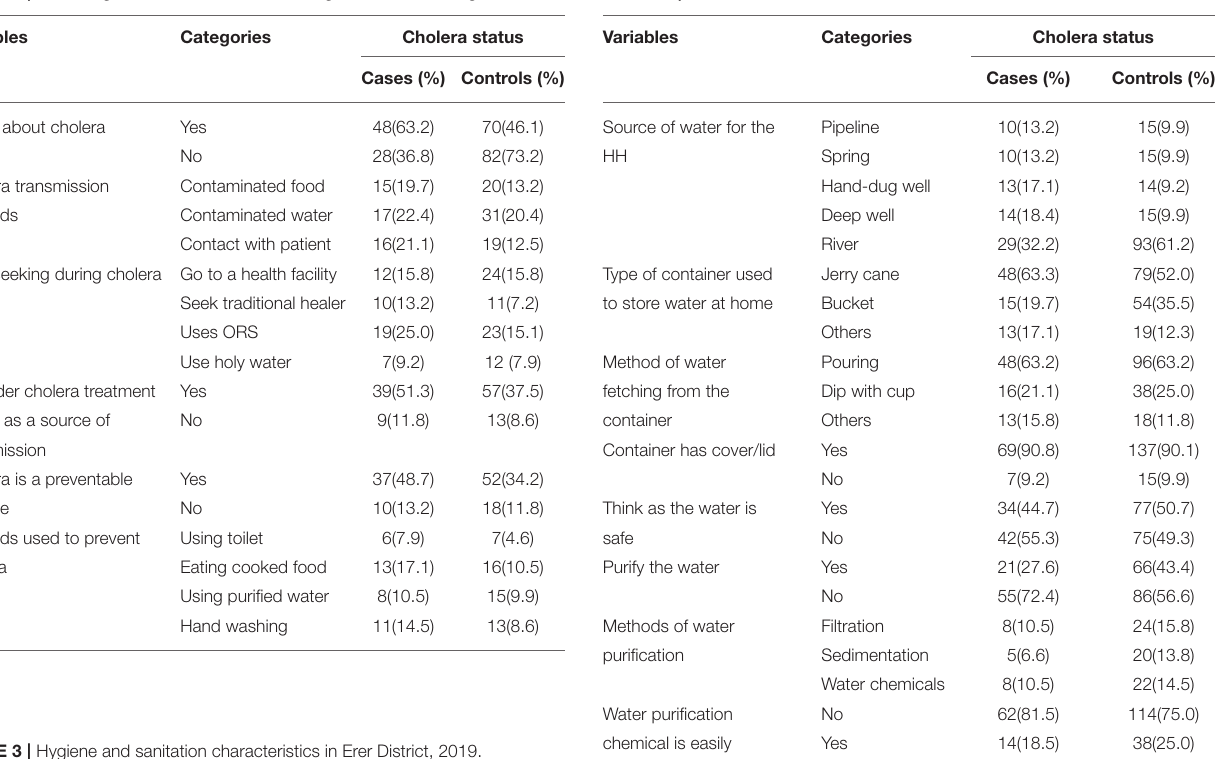
TABLE 4 | Water source of households in Erer District,